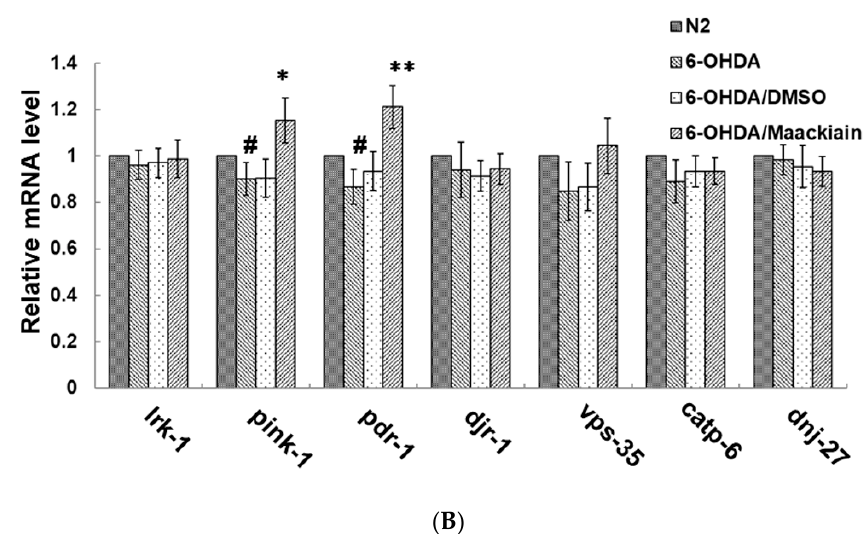
Figure 5. Maackiain (MK) significantly diminished the intracellular reactive oxygen species (ROS) level and increased pink1 and pdr-1 expression in 6-hydroxydopamine (6-OHDA)-exposed N2 C. elegans . MK-pretreated or untreated L3 stage worms were exposed to 6-OHDA for 1 h and were then cultured in the NGM plate for 3 days. ( A ) Thirty randomly selected worms from each experimental group were transferred to the well of a 96-well plate. The intracellular ROS level was evaluated. # shows significant di ff erences between 6-OHDA-exposed and control worms (# p < 0.01); * shows significant di ff erences between the MK-untreated 6-OHDA-exposed worms and MK-pretreated 6-OHDA-exposed worms (** p < 0.01). ( B ) The expression level of PD-associated genes in C. elegans was quantified by qPCR. # shows significant di ff erences between 6-OHDA-exposed and control worms (# p < 0.05); * shows significant di ff erences between the MK-untreated 6-OHDA-exposed worms and MK-pretreated 6-OHDA-exposed worms (* p < 0.05, ** p < 0.01).